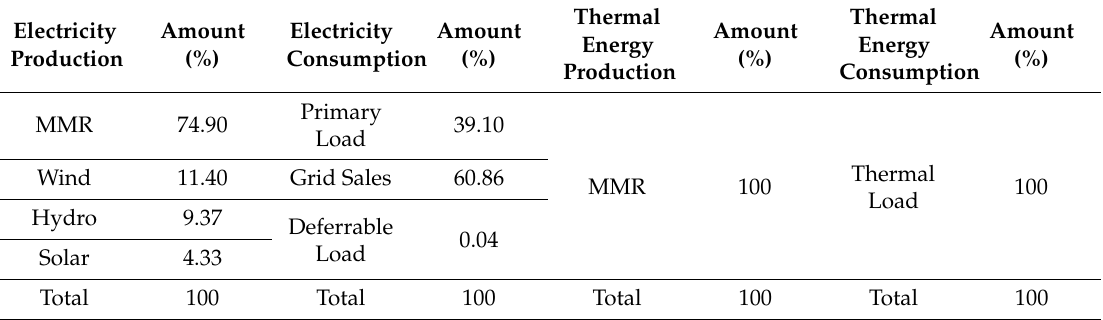
Table 15. Energy production and consumption scenario of grid-connected mode for the first year of project life (case-05).